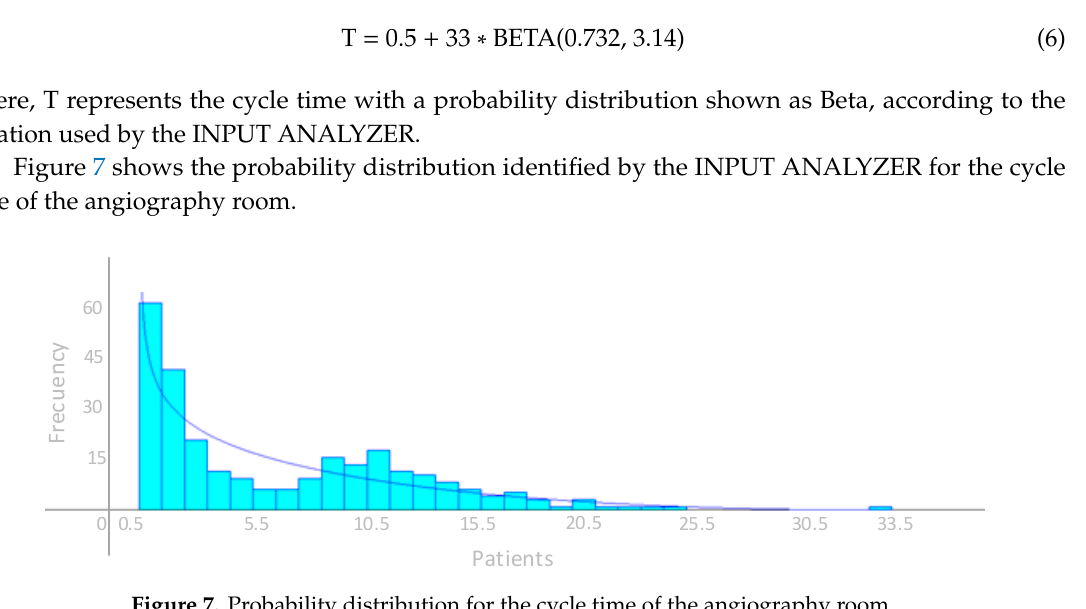
Figure 7. Probability distribution for the cycle time of the angiography room.